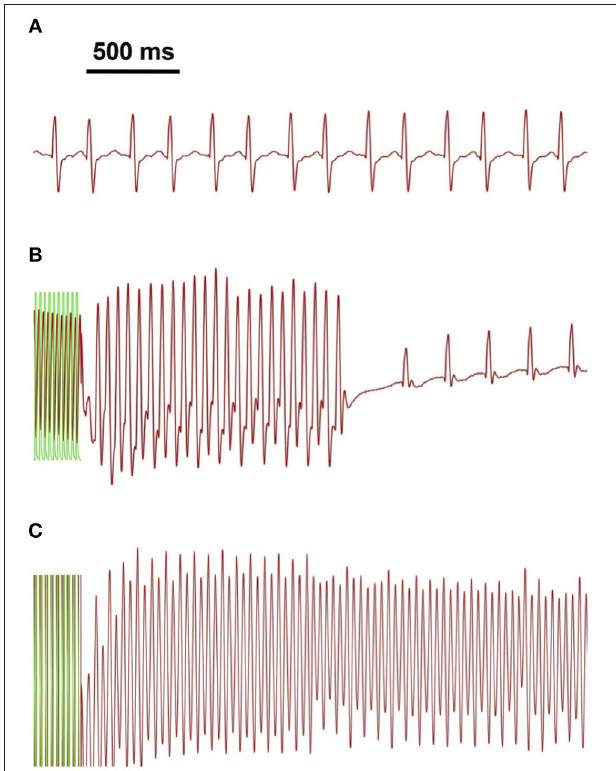
FIGURE 3 | Arrhythmia classification on the basis of electrical signal analysis. Shown are exemplary traces of MAP measurements (in red) for (A) sinus rhythm, (B) non-sustained and (C) sustained arrhythmia. Green overlay indicates part of the electrical pacing used to induce